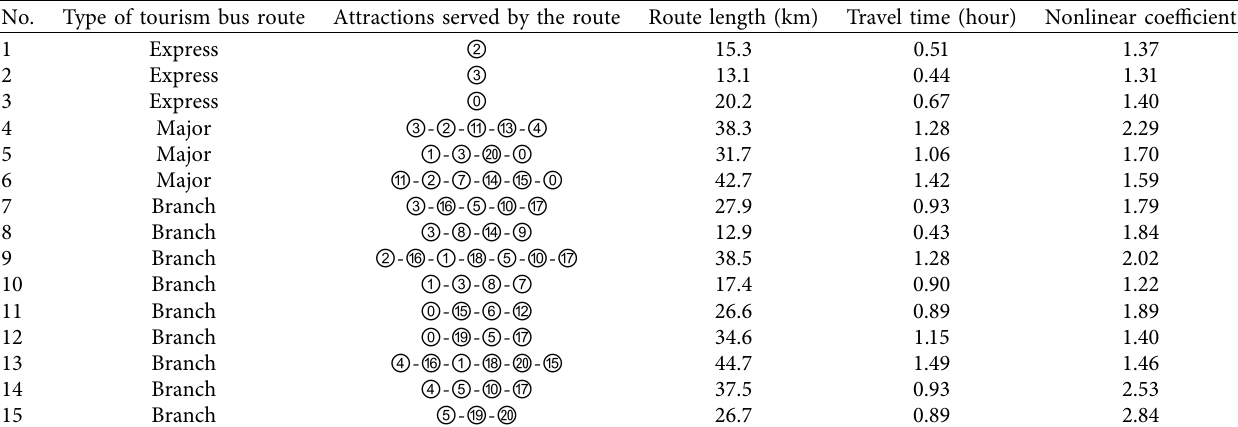
Table 7: Tourism bus routes after design and optimization in the Lishui district.